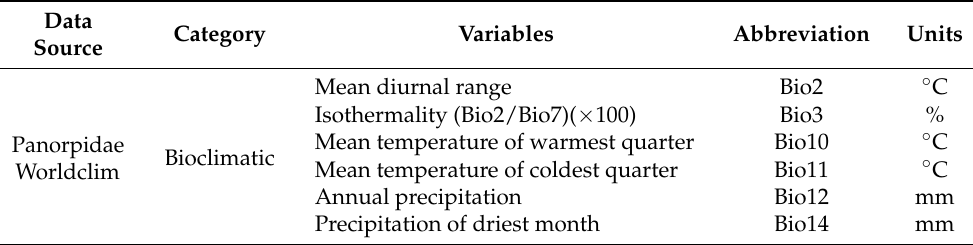
Table 3. Environmental factors used for MaxEnt modeling the habitat suitability distribution of